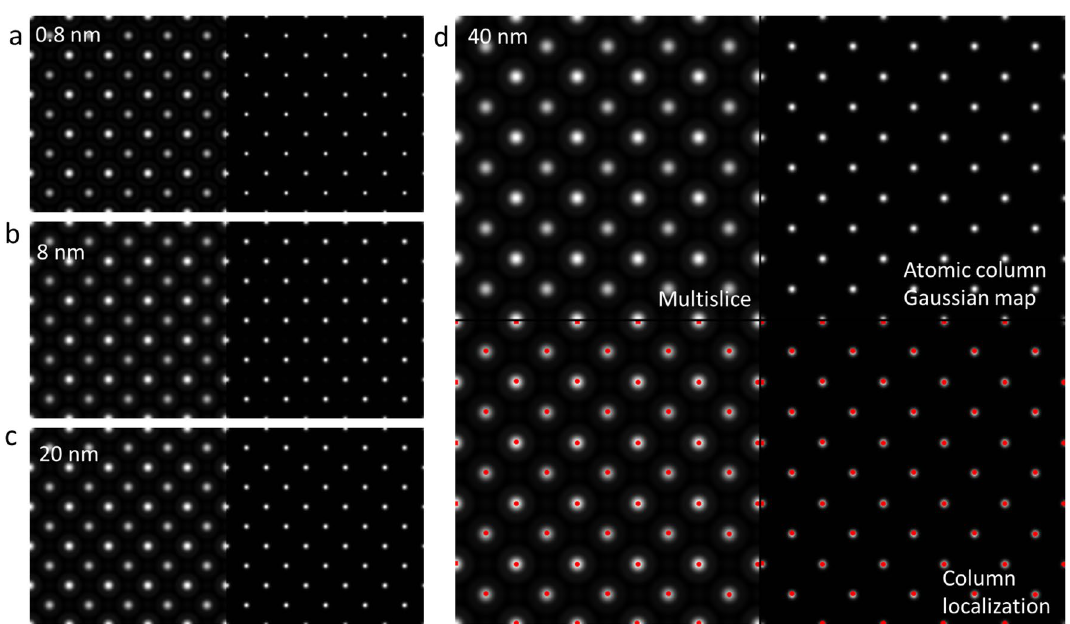
Figure 6. Benchmarking of Otsu’s atom localization method against Faster R-CNN and 2d Gaussian fit.